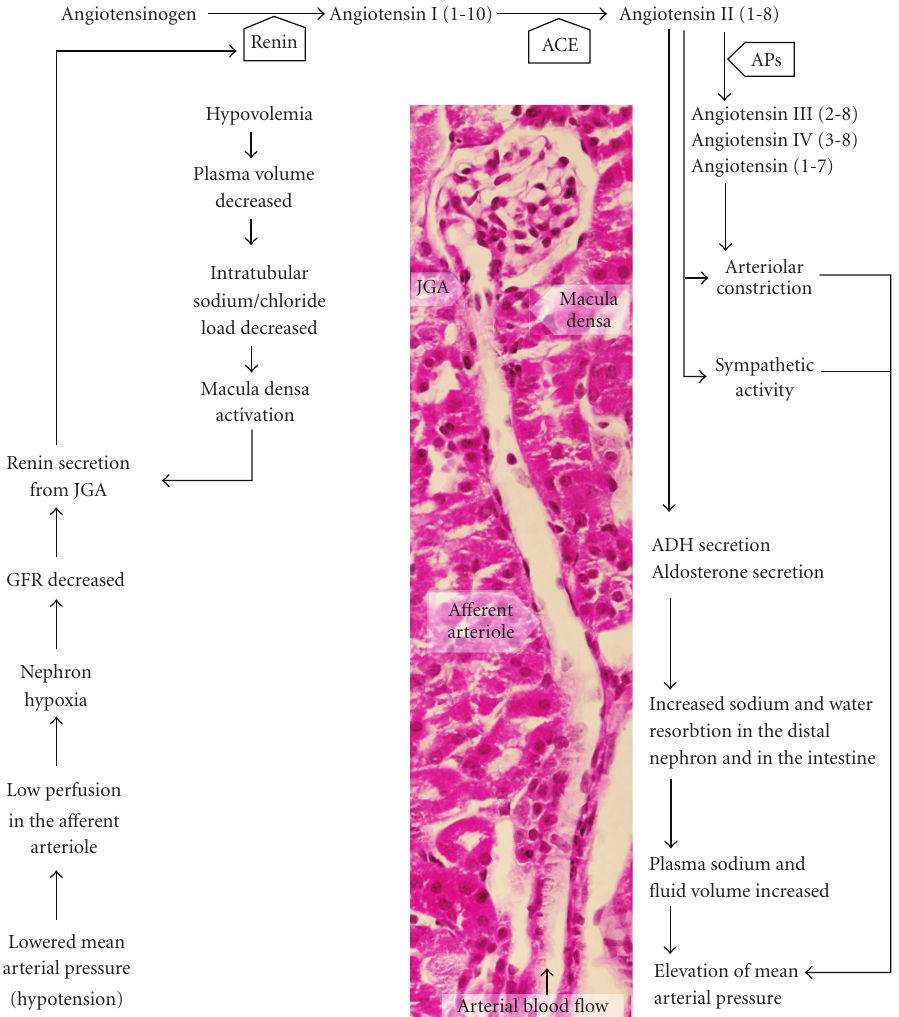
Figure 1: Schematic representation of the RAAS cascade. The main signals activating the RAAS are the reduced nephron perfusion due to lowered arterial mean pressure and the hypovolemia-induced decrease in intratubular sodium/chloride load. Kidney JGA cells produce renin, which activates the RAAS cascade, yielding two main e ff ector molecules, angiotensin II (AngII) and aldosterone. Other vasoactive angiotensins can also be produced from Ang-II by the action of di ff erent aminopeptidases (APs). The main ouputs of RAAS activation are arteriolar vasoconstriction and fluid retention, which both elevate mean arterial blood pressure. PPAR γ is expressed in JGA, the source of renin and in the distal collecting ducts, targets of aldosterone. Histological image shows a renal glomerule with the longitudnal section of the a ff erent arteriole in mouse kidney (hematoxylin-eosin staining, N: 400x).